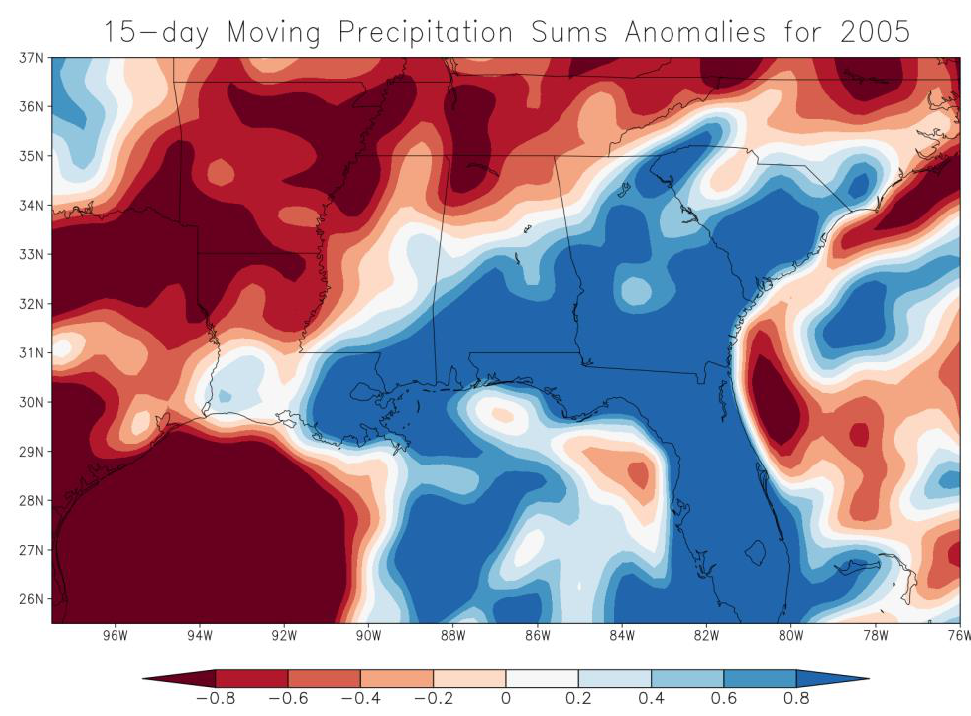
Figure 11. Precipitation anomalies for the 2005 warm season. Note the elevated precipitation along the Gulf Coast and into Georgia and the Carolinas coupled with the anomalously dry conditions in the northern and western portions of the study